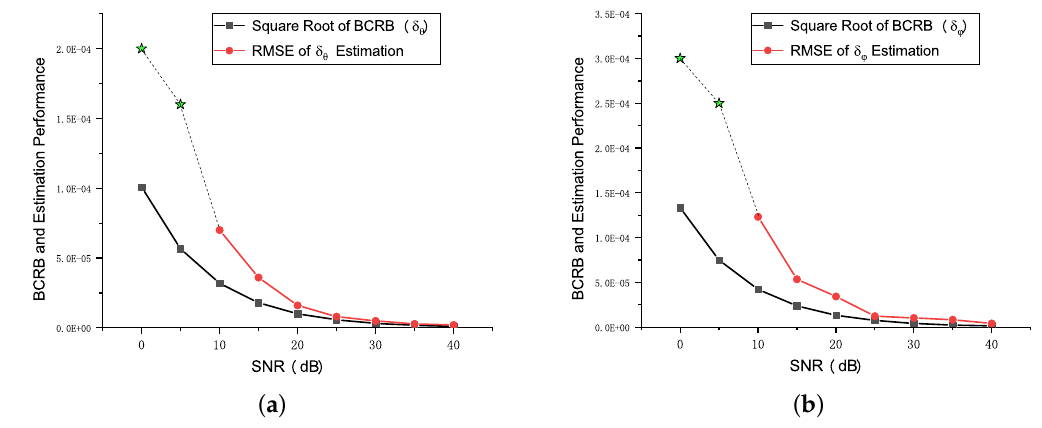
Figure 9. Comparison between square root of BCRB and the RMSE of off-grid bias estimation: ( a ) Off-grid bias for θ ; ( b ) Off-grid bias for ϕ